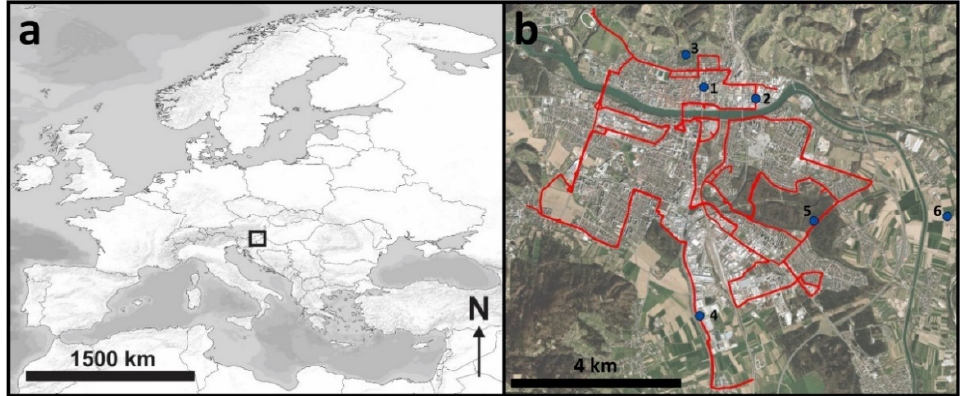
Figure 1. The geographic position of the study area ( a ); stationary measurements (blue dots, 1 = the medieval city center (Industrial, commercial, public, military, and private units); 2 = the Melje industrial zone (Industrial, commercial, public, military, and private units); 3 = green urban area Mestni park (Green urban areas); 4 = the Tezno industrial zone (Industrial, commercial, public, military, and private units); 5 = Stražun forest (Forests); 6 = rural background (Arable land)), and the mobile measurement route (red lines) ( b ).